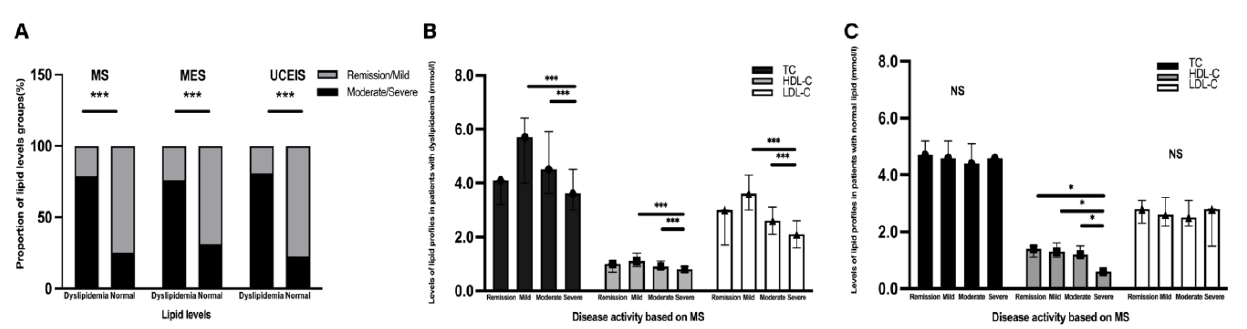
Figure 2. Correlation between lipid levels and disease activity. ( A ) The proportion of patients with dyslipidaemia and normal lipid levels is presented by bar plots and stratified according to disease activity based on MS, MES, and UCEIS. ( B , C ) Correlation between lipid profiles and disease activity based on MS in patients with dyslipidaemia and normal lipid levels. ( B ) Bar plots of levels of TC, HDL-C, and LDL-C in different groups based on disease activity in the patients with dyslipidaemia. ( C ) Bar graphs of the levels of TC, HDL-C, and LDL-C in different groups based on disease activity in patients with normal lipid levels. The proportion of lipid levels in patients with dyslipidaemia and normal serum lipid levels is presented by bar plots and stratified according to disease activity. The chi-square test was performed to analyse statistical significance. MS, Mayo score; MES, Mayo Endoscopic Score; UCEIS, Ulcerative Colitis Endoscopic Index of Severity; NS, no significance. Significant differences were adjusted for multiple tests by Bonferroni correction. Significant p -value < 0.05. * p < 0.05, *** p < 0.001.